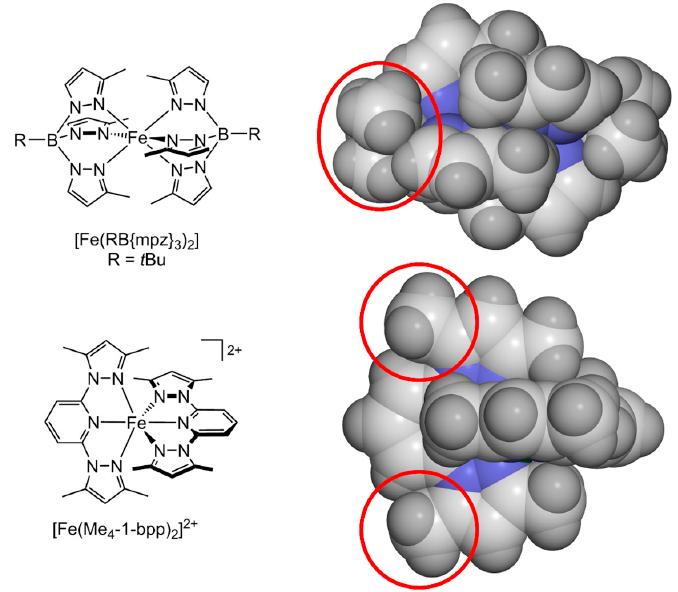
Figure 2. Structures and crystallographic space-filling views of two complexes exhibiting low-spin states stabilized by the highlighted steric repulsions at the periphery of the molecules [55,57]. The orientation of the space-filling views is similar to the structure diagrams. Color code: C, white; H, pale gray; Fe, green; N, blue.